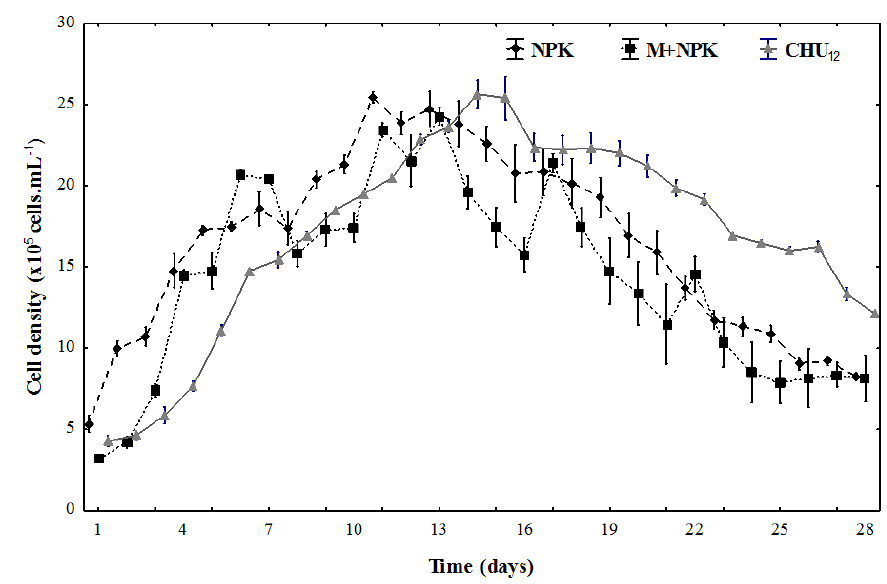
Figure 1. Growth of Ankistrodesmus gracilis in three different media: inorganic fertilizer (NPK), macrophyte with inorganic fertilizer (M+NPK) and commercial (CHU ). Data represent mean ± SD of three replicates per medium 12 (NPK, M+NPK and CHU 12